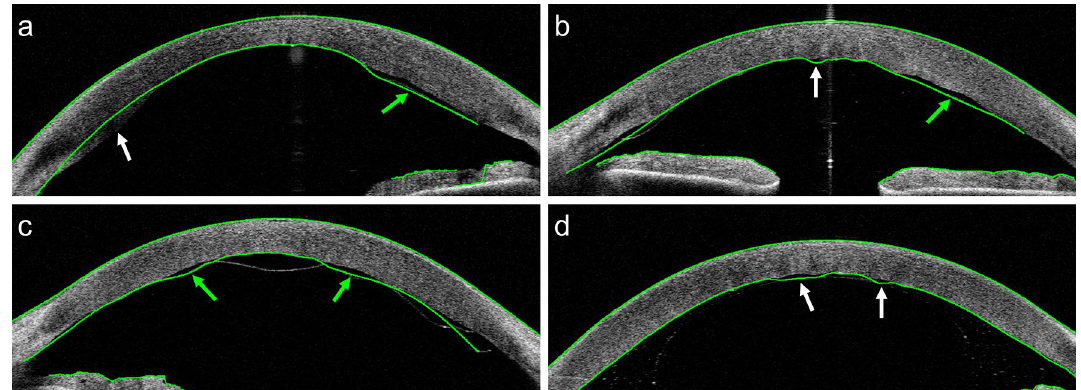
Figure 2. AS-OCT B-scans collected from patients after DMEK surgery. The green lines represent delineations of the (corneal) interfaces by the built-in software of the OCT system. These examples were selected to show the types of delineation errors encountered. In ( a )–( c ) the delineation partly follows the DMEK graft (green arrows) instead of the posterior interface. Other types of mistakes are indicated by white arrows: ( a ) Some of the posterior part of the cornea is missed. ( b ) The delineation does not follow the irregularly shaped interface in the center. ( d ) The system confuses the boundaries of the gas bubble used in DMEK with the posterior corneal